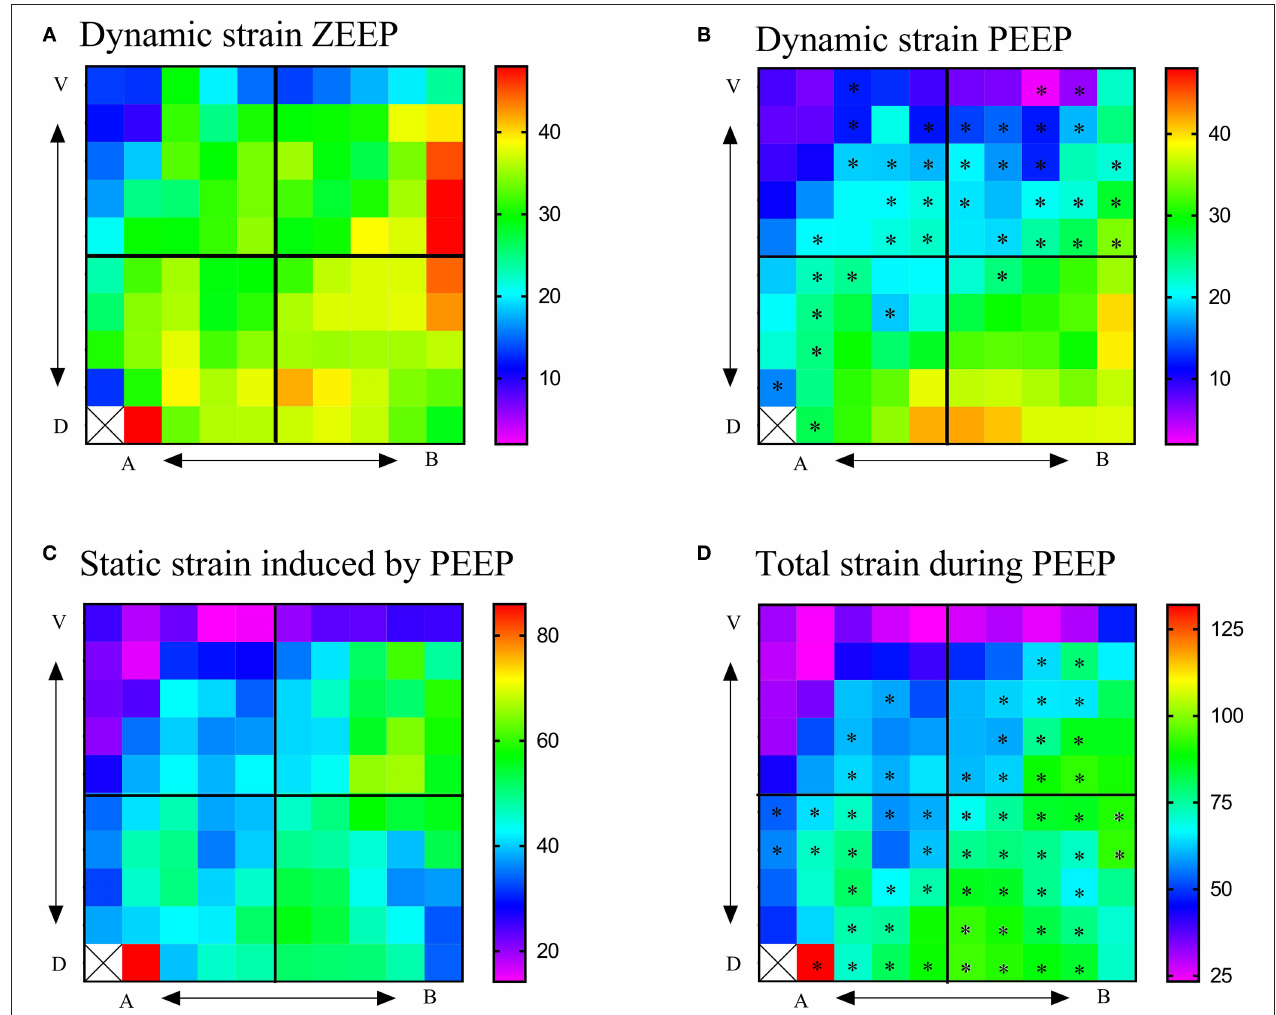
FIGURE 5 | Regional 2D strain maps during ZEEP and PEEP. (A) Regional 2D maps of dynamic strain during ZEEP, (B) regional 2D maps of dynamic strain during PEEP, (C) regional 2D maps of static strain induced by PEEP, (D) regional 2D maps of total lung strain (dynamic + total) during PEEP. Total strain during ZEEP was considered the same as that shown in Figure 3A . V, ventral; D, dorsal; A, apical; B, basal. Color palettes represent the range of strains in percentage, with 0 corresponding to 0% and 1-100% of the total lung tissue. * p < 0.05 with respect to